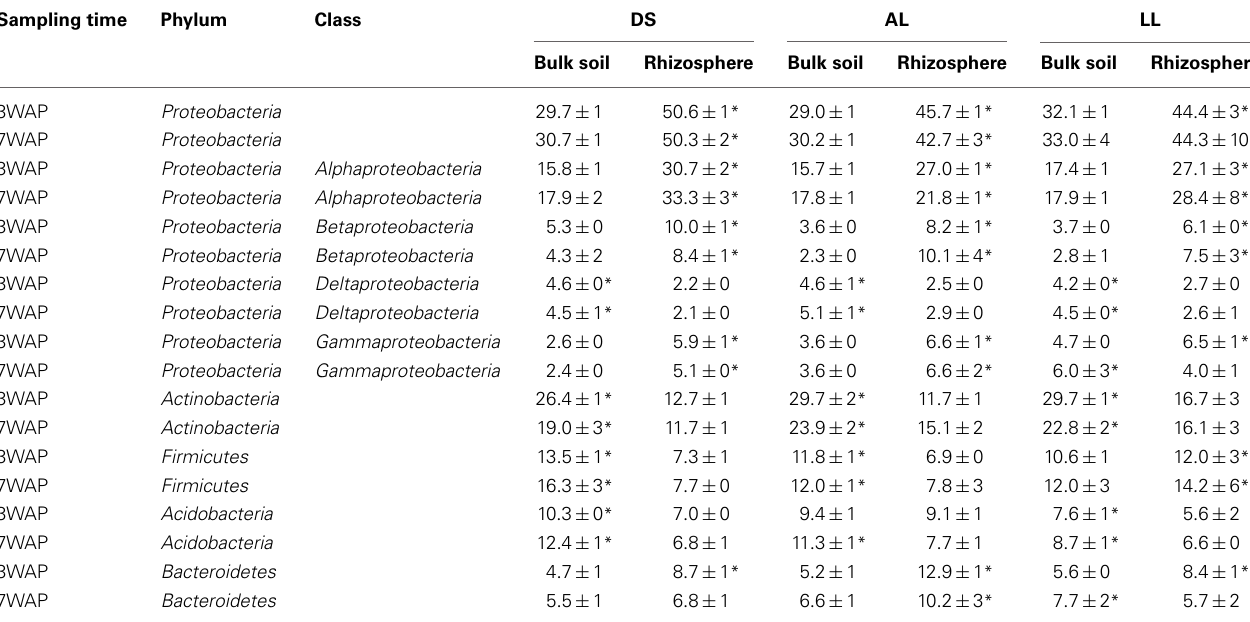
Table 2 | Relative abundance of phyla in bulk soil and rhizosphere. Sampling